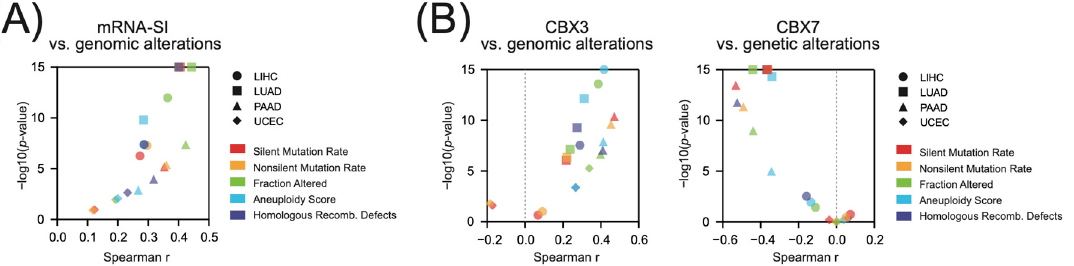
Figure 8. The association between CBX3 and CBX7 expression and genomic alterations in selected TCGA tumors. ( A ) Cancer stemness positively correlates with genomic alterations in LIHC (circle), LUAD (square), PAAD (triangle), and UCEC (rhombus) tumors. Several distinct scores were used to determine the association between cancer stemness (mRNA-SI) and distinct genomic alterations: silent (red) or non-silent mutation rate (yellow), the fraction of altered genome (green), aneuploidy score (light blue), homologous recombination defects score (purple) in selected cancer types. ( B ) The expression of CBX3 positively, while CBX7 negatively correlates with genome alterations in tested tumors. Tumor types are coded with figures accordingly: circle—LIHC, square—LUAD, triangle— PAAD, rhombus—UCEC, while genomic aberrations are color-coded as follows: red—silent mutation rate, yellow—non-silent mutation rate, green—the fraction of altered genome, light blue—aneuploidy score, purple—homologous recombination defects